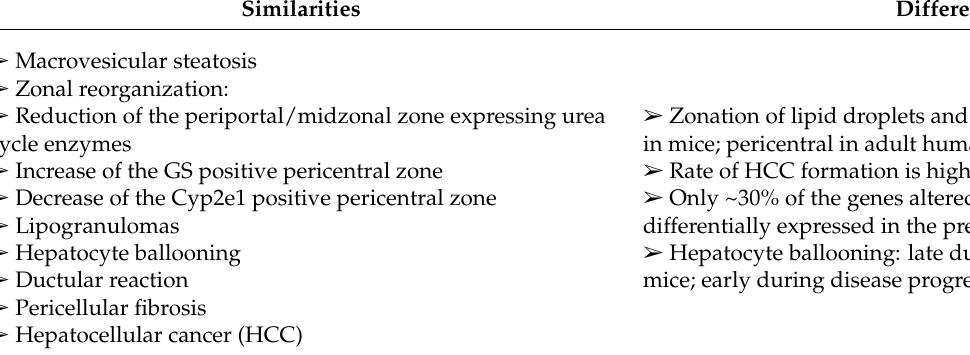
Table 6. Similarities and differences of the present NAFLD mouse model and human NAFLD, concerning the key features analyzed in the present study. Similarities